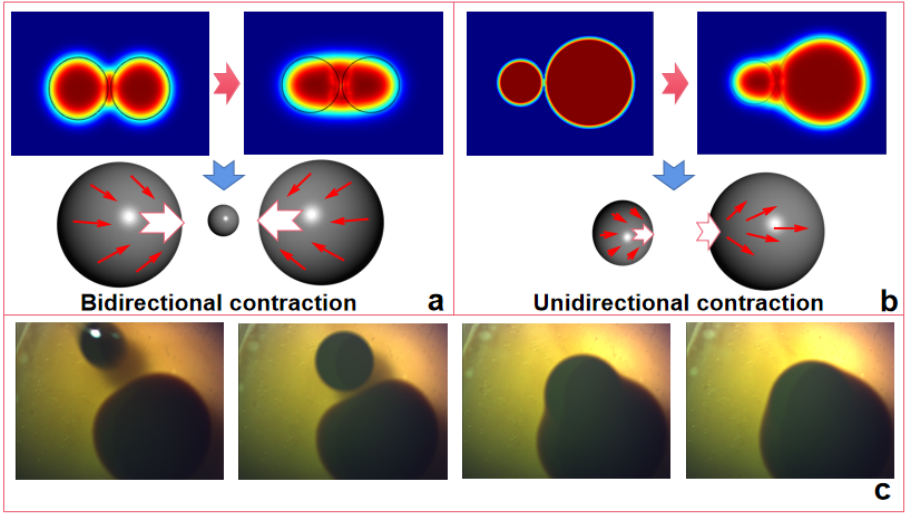
Figure 3. The movement trend of liquid flow in oil droplet during coalescence. ( a ) Schematic diagram of coalescence of oil drops of the same size. ( b ) Schematic diagram of coalescence of oil drops with different sizes. ( c ) Microscopic observation results of oil droplet coalescence with different sizes. In addition, due to the influence of the interaction force between the two oil droplets, the pressure and the fluid velocity of the two oil droplets at each position in the water phase can significantly change. The fluid velocity distribution of the two oil droplets is shown in Figure